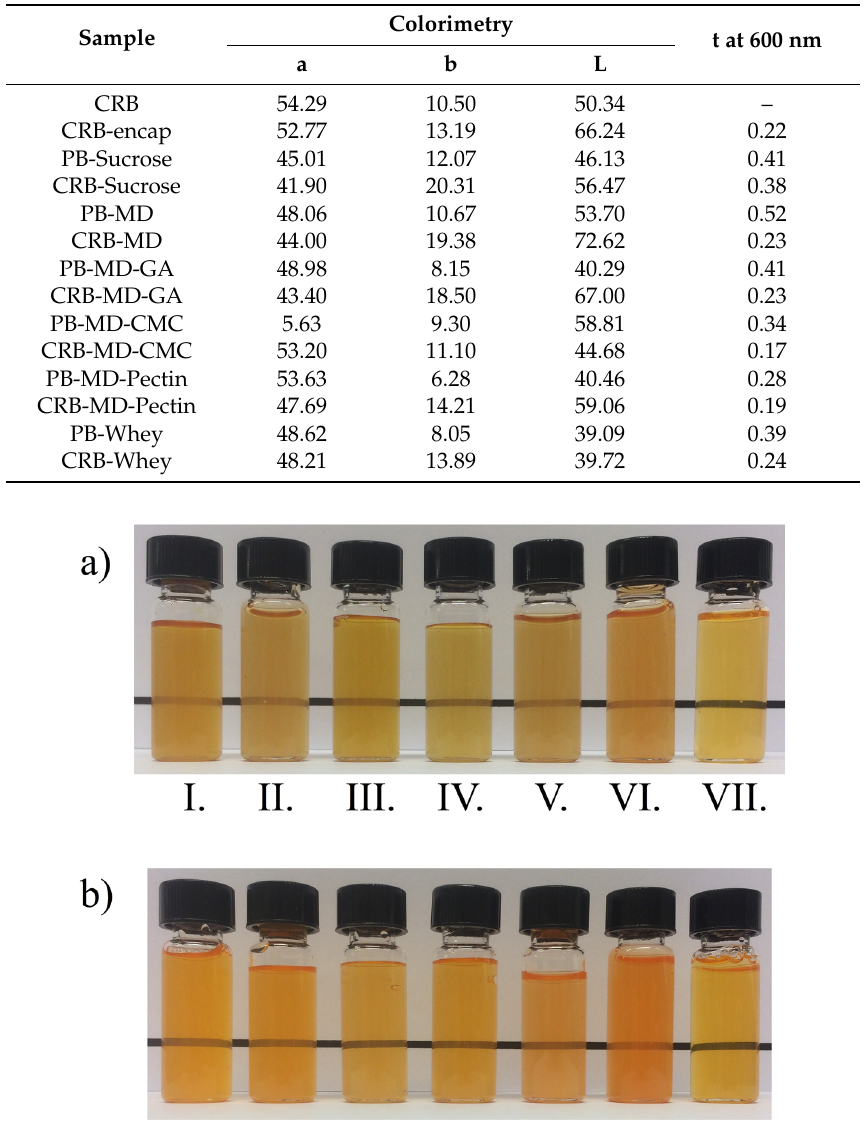
Table 3. CIE Lab parameters a, b, L, and turbidity (t) measurements of water dispersions containing 1.5 mg/mL of PB microcapsules, 0.3 mg/mL of CRB microcapsules, or 0.048 mg/mL of CRB and CRB-encap.